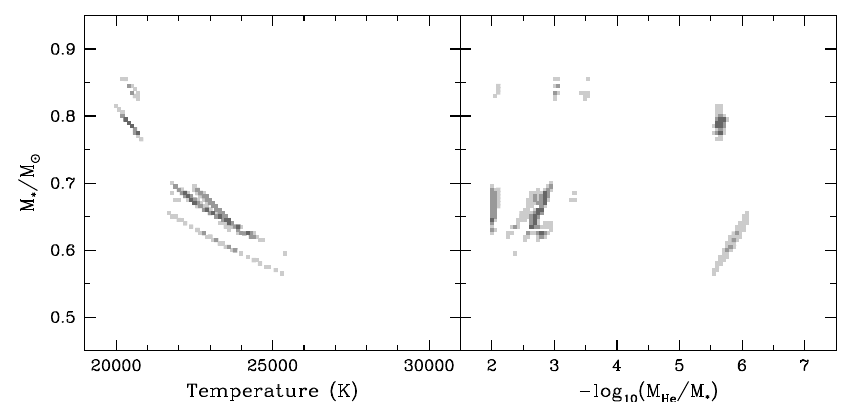
Fig. 1. Front and side views of the model-space for the pulsation periods observed in GD 358 showing the families of good matches to the observations. Each point in the left panel corresponds one-to-one with a point in the right panel. The shade of each point is an indication of how well the model matches the observations: root-mean-square period differences are less than 3 seconds (lightest), 2.75 seconds, and 2.5 seconds. High mass models can be ruled out based on the luminosity of GD 358 from its observed